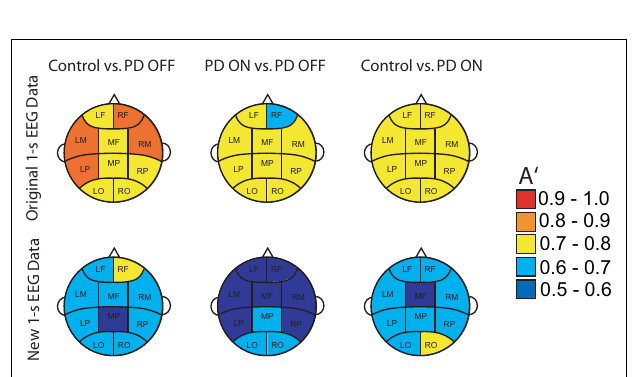
FIGURE 7 | Classification performance of three different classifications using A (cid:48) on all the original 1-s trials of EEG used for training and new 1-s data trials from the same subjects